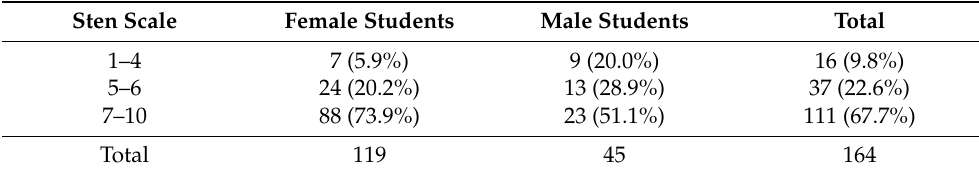
Table 1. The distribution of respondents in different sten scales.